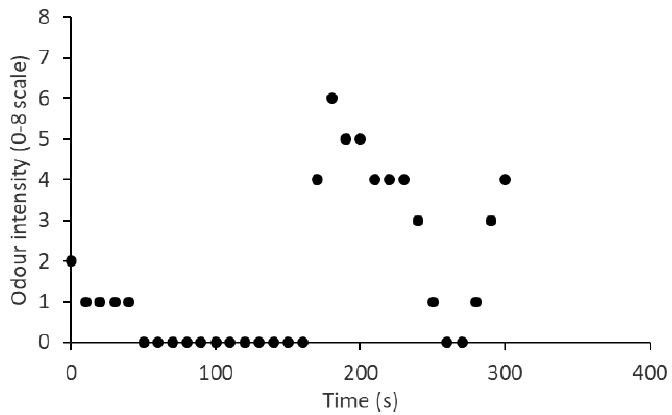
Figure 2. A sample of odour intensity measurements for a 5 minute period, reported by a human